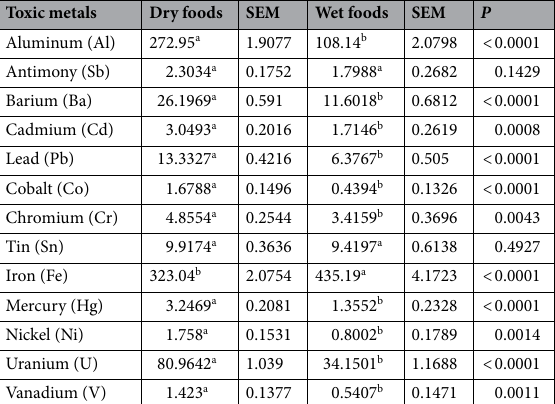
Table 6. Comparison between the detected toxic metals concentrations (mg/kg) in dry and wet foods in mg/ kg of dry matter. SEM standard error mean, P probability of significance. a,b Means followed by different letters in the lines differed (P <